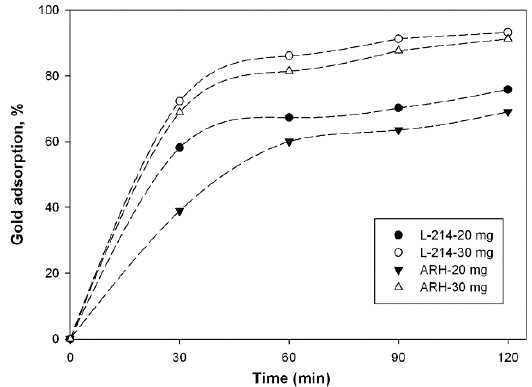
Figure 8. Gold adsorption (%) as a function of time by the ARH and L-214 (25 °C, 100 rpm, pH = 0.51, 10 mL waste sol.).